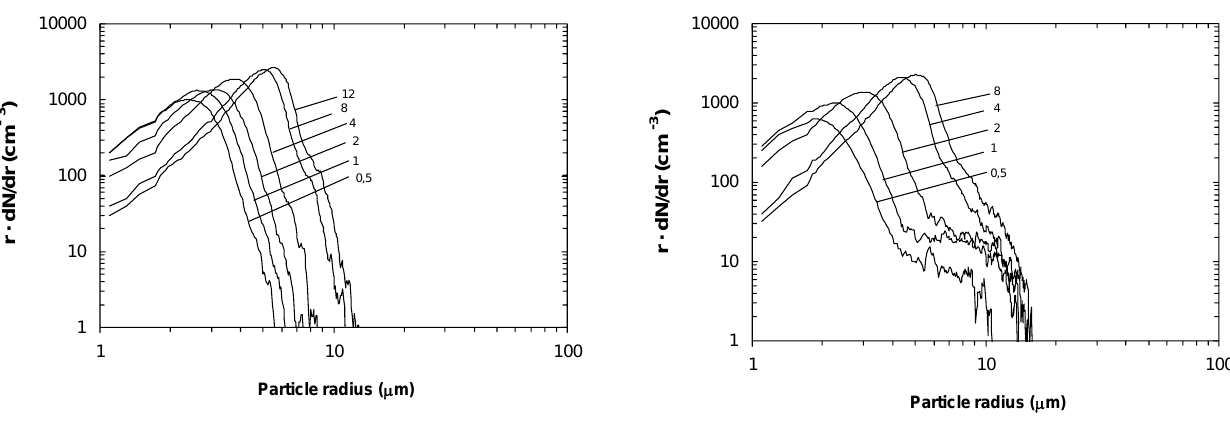
Figure 4. Observed evolution of cloud drop spectrum at introduction of salt powder into the 3 Fig. 4. Observed evolution of cloud drop spectrum at introduc- BCC with the mass concentration of 1.1 mg/m 3 (numbers at the curves – time (min.) after the 4 tion of salt powder into the BCC with the mass concentration of beginning of cloud medium formation). 5 1.1mg/m 3 (numbers at the curves – time (min.) after the beginning of cloud medium